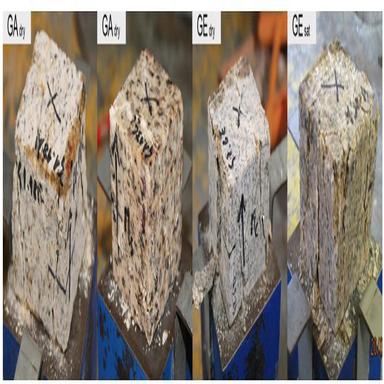
Examples of granite specimens tested under dry mass and saturated conditions, exhibiting the most observed types of failures.